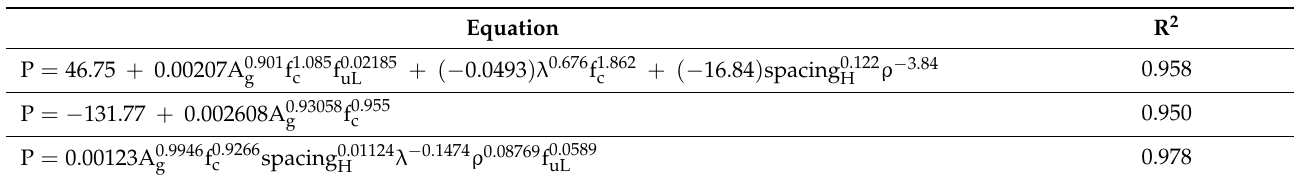
Figure 13. Comparison of experimental and predicted (Equation (24)) p values. Table 2. Proposed